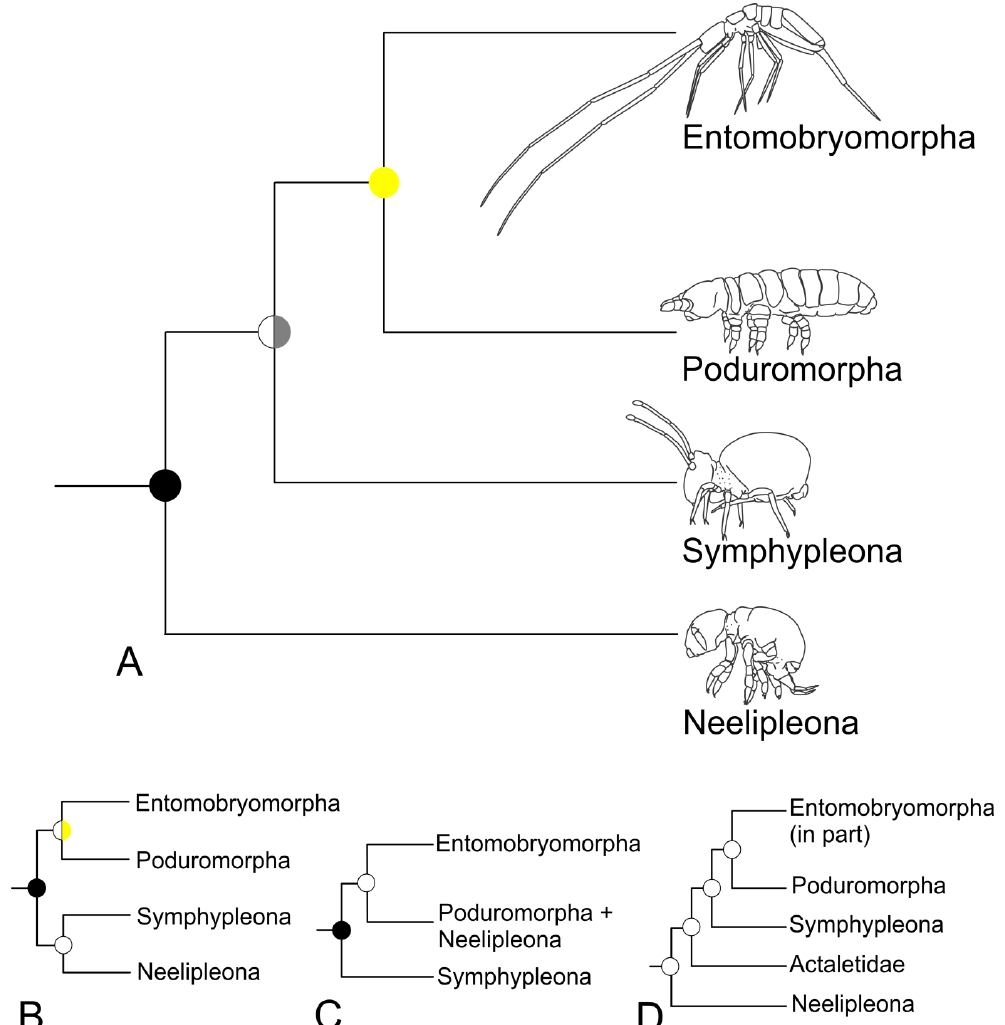
Figure 2. Summarized phylogenetic relationships of the Collembola orders obtained in this study: ( A ) topology of ML_1, ML_2 and ML_4 trees (nodes depict only ML_1 support levels); ( B ) topology of ML_3 tree; ( C ) topology of BI tree; ( D ) topology of MP tree. Node circles represent SH-aLRT support (left side) and bootstrap values (right side), respectively, for ML trees, posterior probability for BI tree, and maximum parsimony bootstrap for MP tree. Colors represent the following scores: black = 100 (1 for BI); yellow = 95 – 99.9 (0.95 – 0.99 for BI); grey = 90 – 94.9 (0.9 – 0.94 for BI); white < 90 (<0.9 for BI).